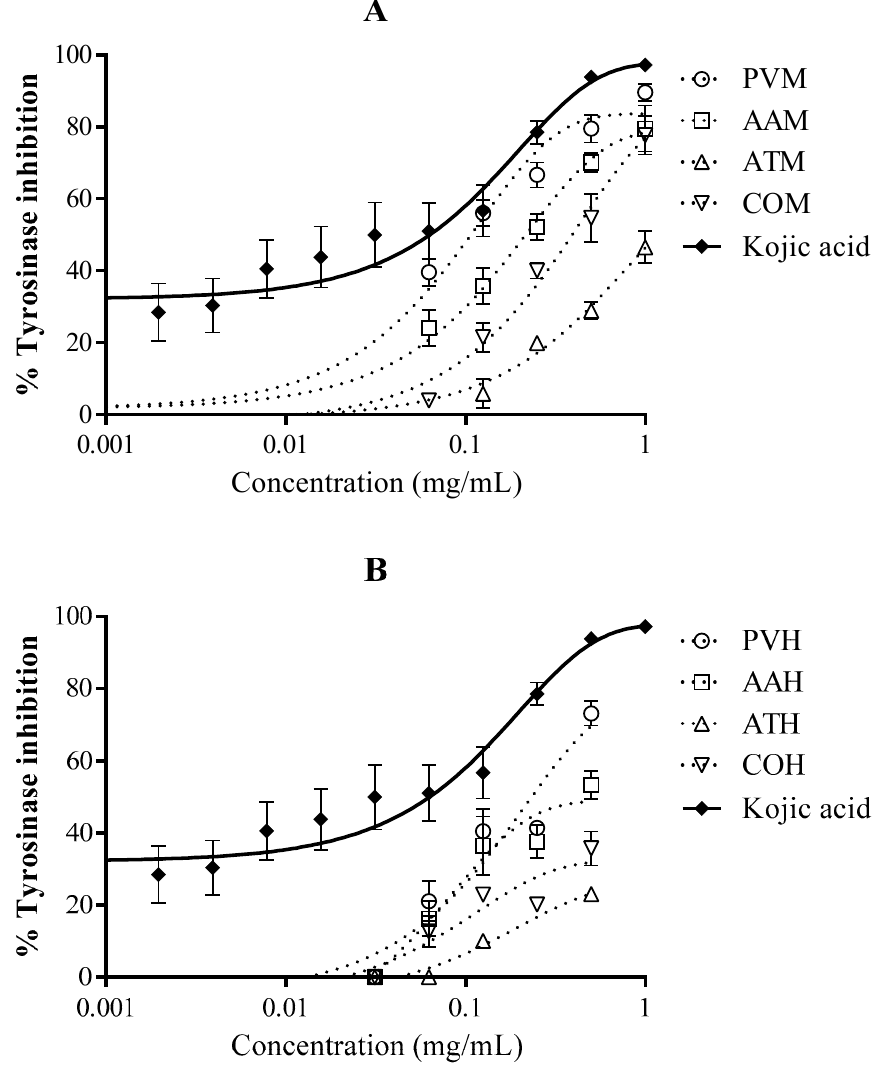
Figure 4. Inhibition of tyrosinase by methanolic ( A ) and hexane ( B ) extracts. Kojic acid was used as reference.